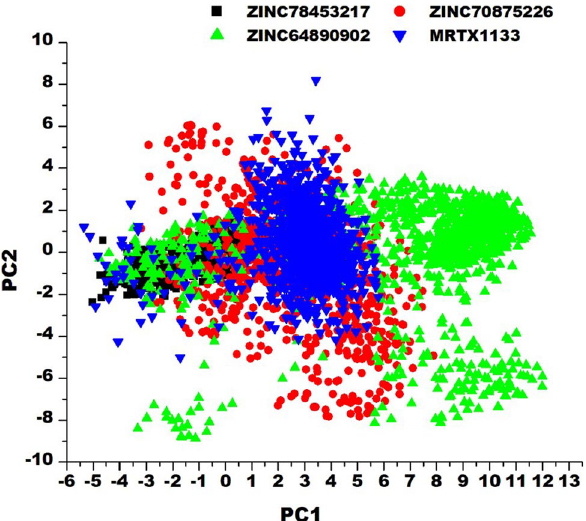
Figure 9. Principal component analysis of the motions of the selected compounds at the allosteric binding site of KRAS G12D